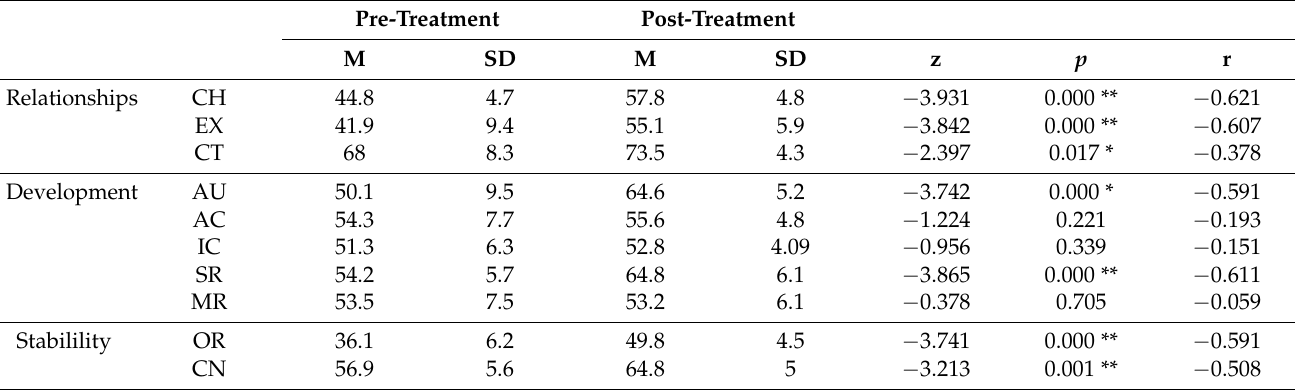
Table 10. Pre-post comparison of the multimodal group. Family climate. Pre-Treatment